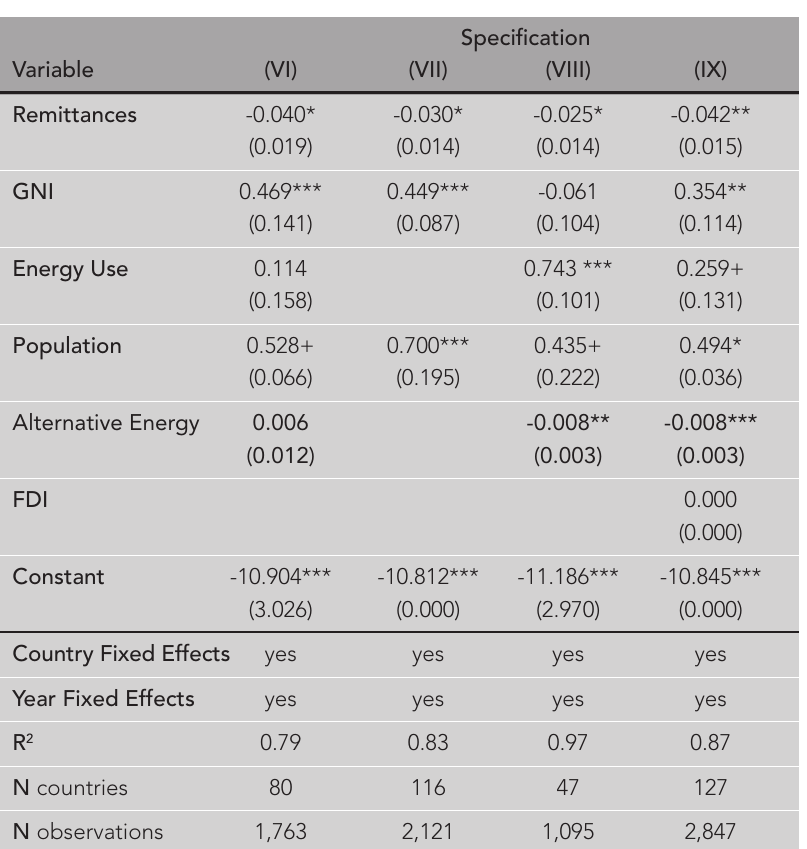
Table 4. Robustness